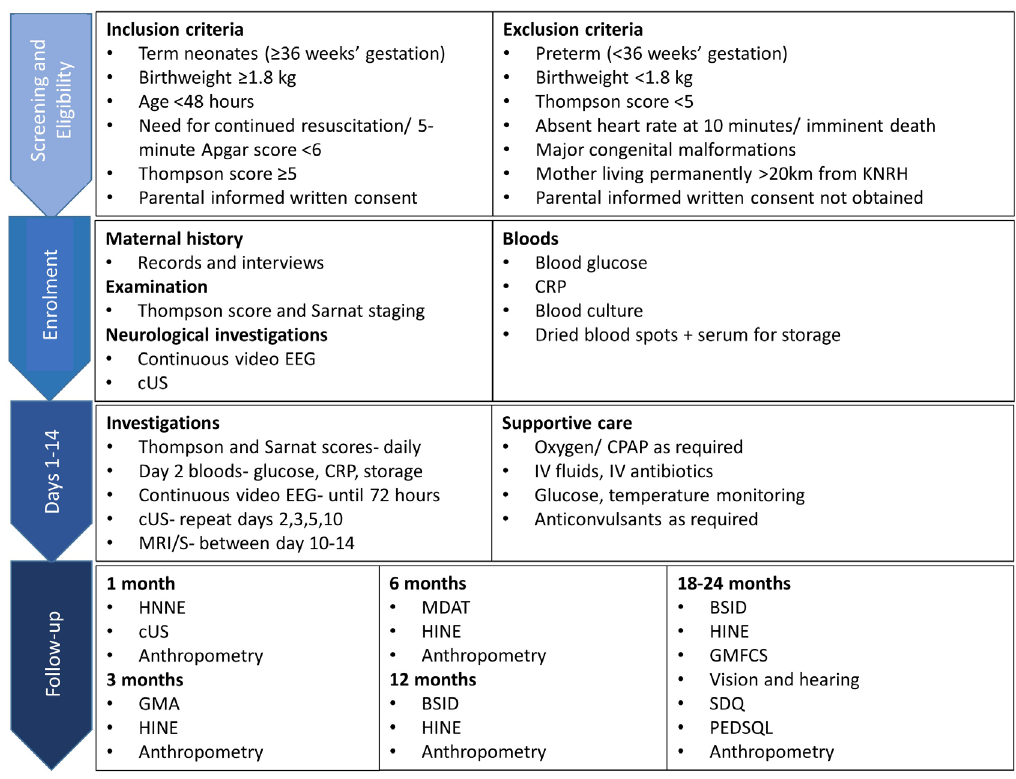
Figure 2. Study procedures and follow-up. Study procedures, including inclusion/ exclusion criteria, from screening to follow-up. Abbreviations: KNRH= Kawempe National Referral Hospital; EEG= Electroencephalogram; cUS= Cranial Ultrasound; CRP= C-Reactive Protein; EDTA= Ethylenediaminetetraacetic acid; MRI= Magnetic Resonance Imaging; MRS= Magnetic Resonance Spectroscopy; CPAP= Continuous Positive Airway Pressure; IV= Intravenous; HINE= Hammersmith Infant Neurological Examination; GMA= Prechtl’s Assessment of General Movements; MDAT= Malawi Development Assessment Tool; BSID-III= Bayley Scales of Infant and Toddler Development III; GMFCS= Gross Motor Function Classification System; PEDSQL= Pediatric Quality of Life Inventory; SDQ= Strengths and Difficulties